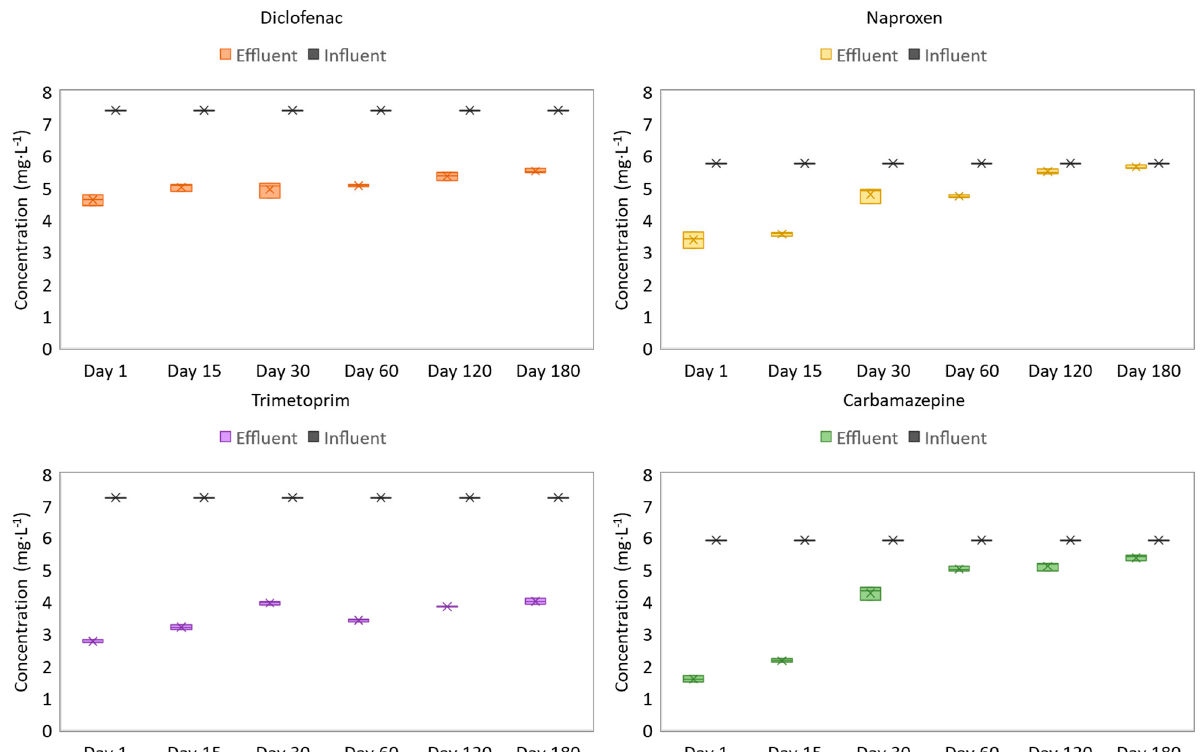
Figure 4. Effluent and influent concentrations of pharmaceutical compounds added in PB.